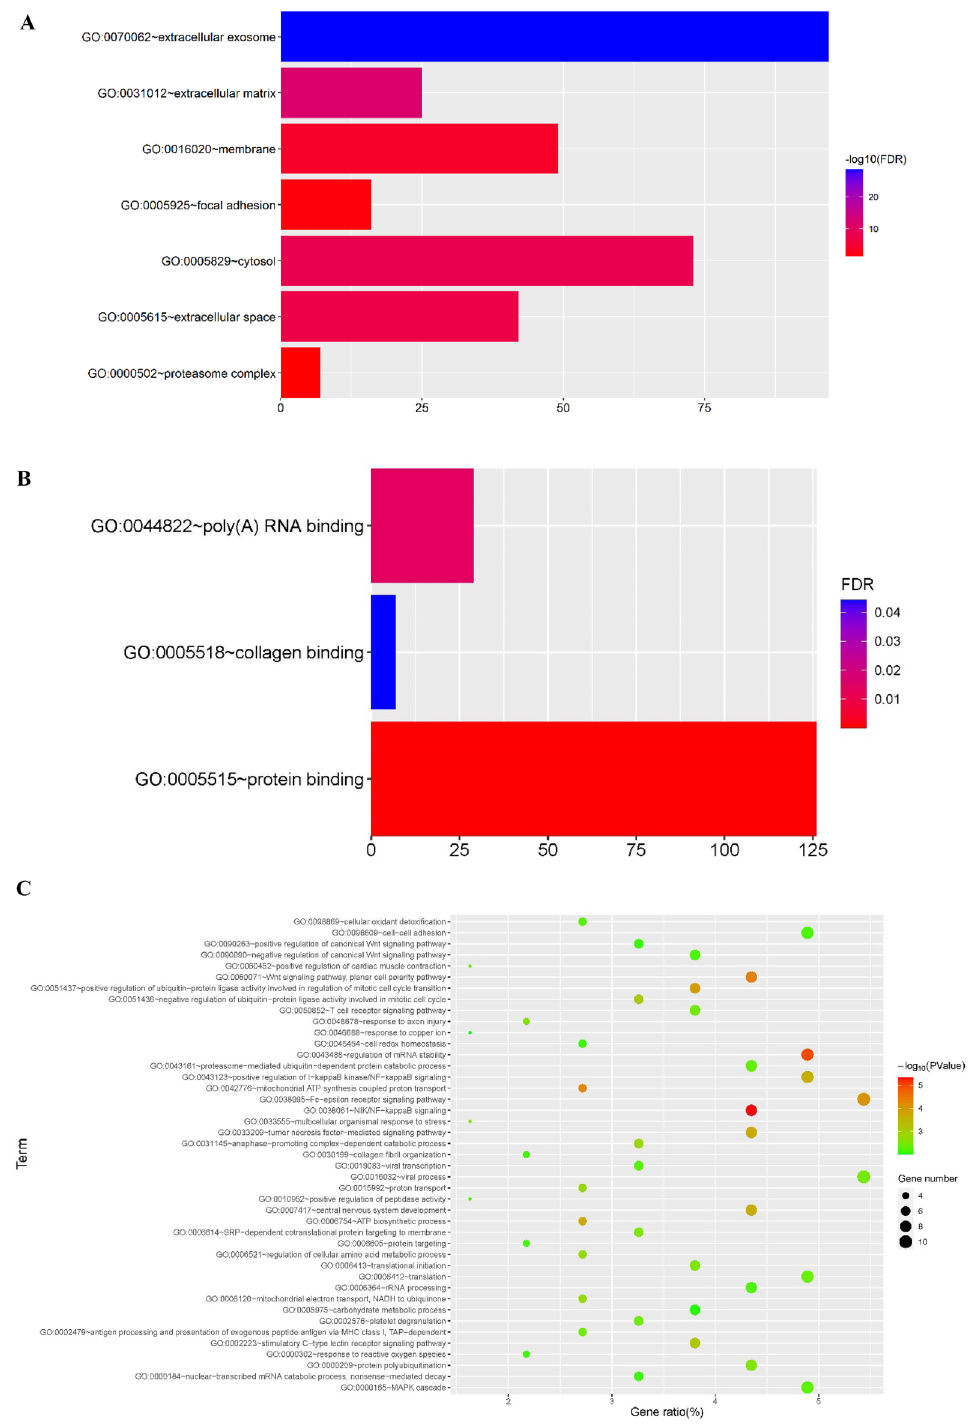
Figure 5. The analysis of GO (Cellular Component, Molecular Function and Biological Process) enrichment for intervertebral disc degeneration. ( A ) Genes in the hub module associated with intervertebral disc degeneration significantly enriched in 7 cellular components, ( B ) 3 items of molecular function and ( C ) 43 items of biological